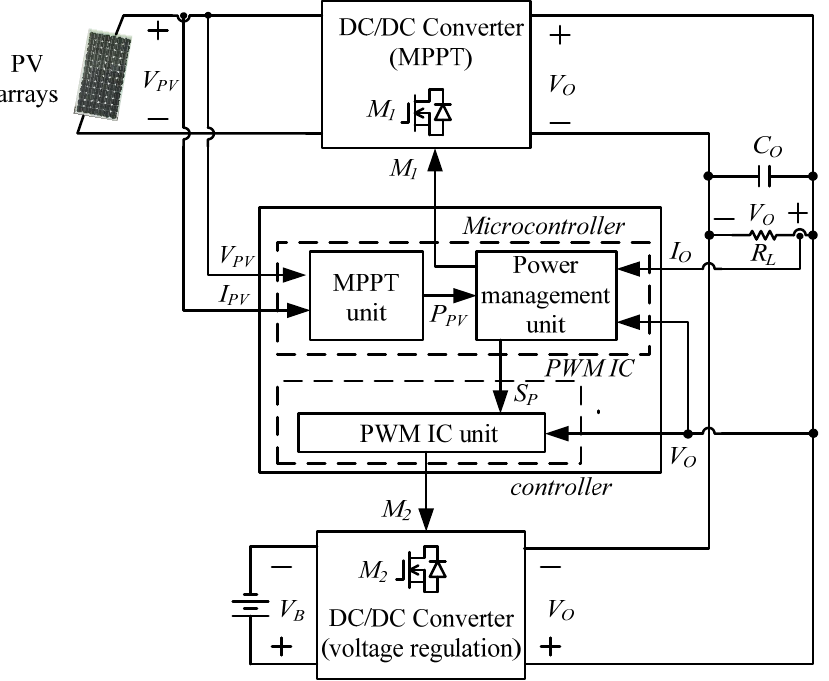
Figure 6. Derivation of the proposed interleaved boost converter with coupled